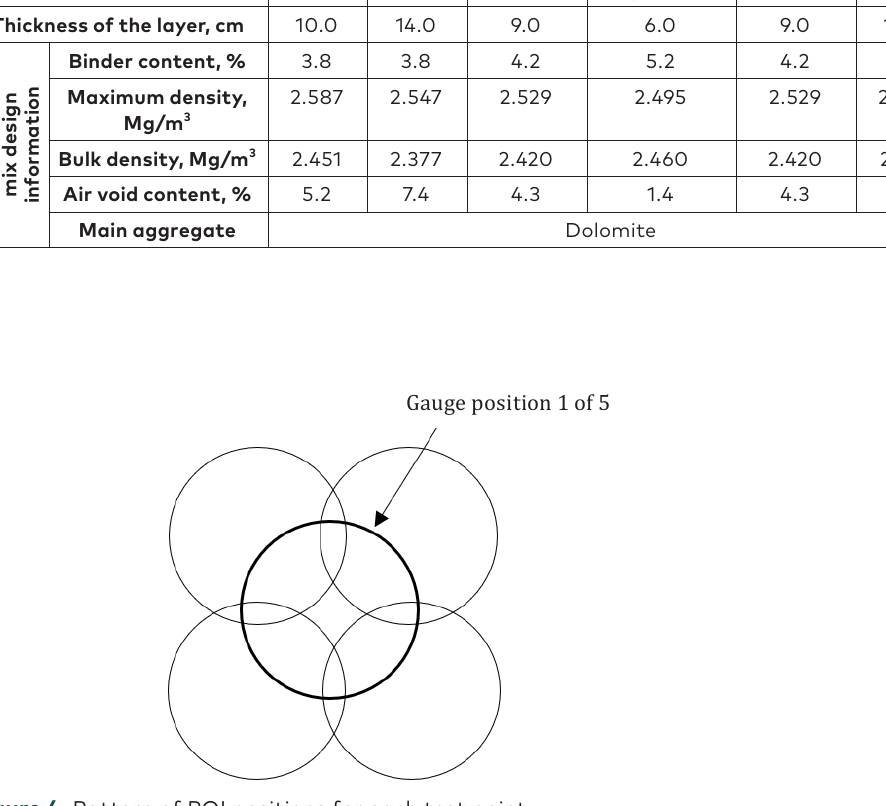
Figure 4. Pattern of PQI positions for each test point